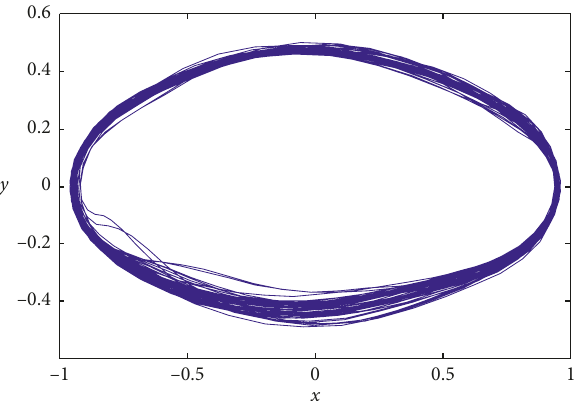
Figure 7: Orbits at the position of pedestal looseness (looseness clearance